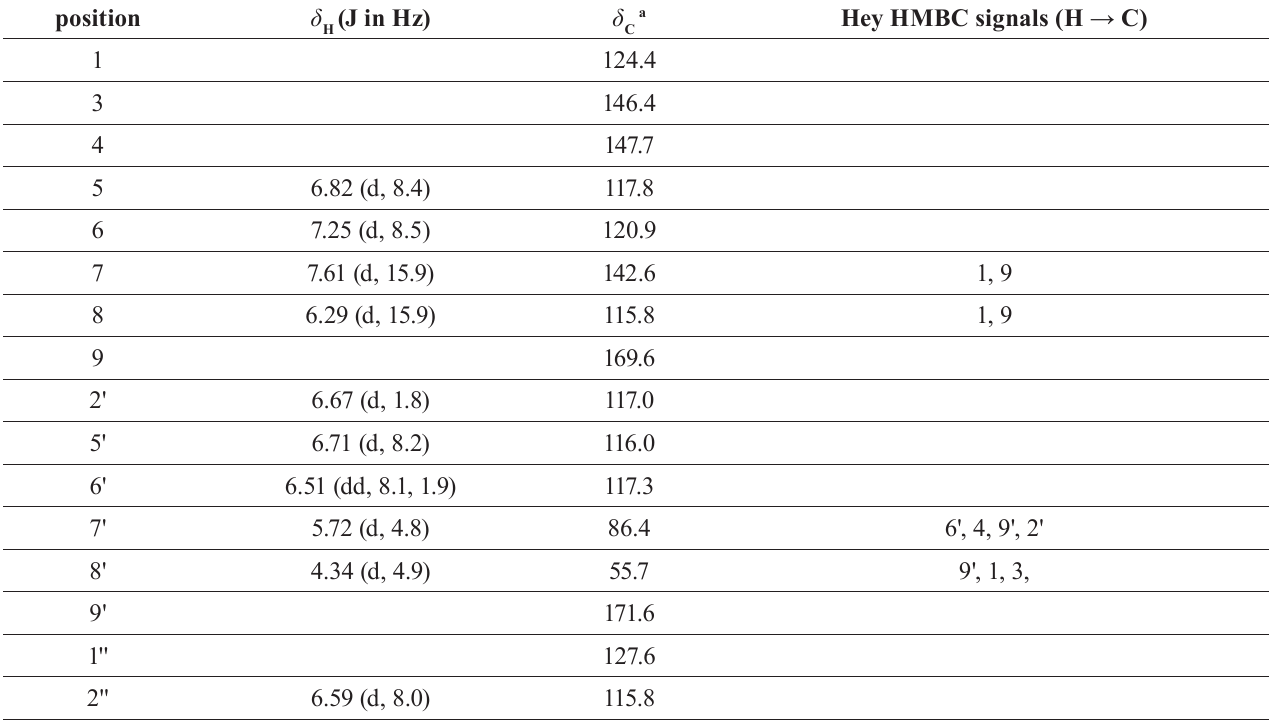
OD) of compound 16 (7’R, 8’ R, 8’’R, 8’’’R)-epi- salvianolic acid 3